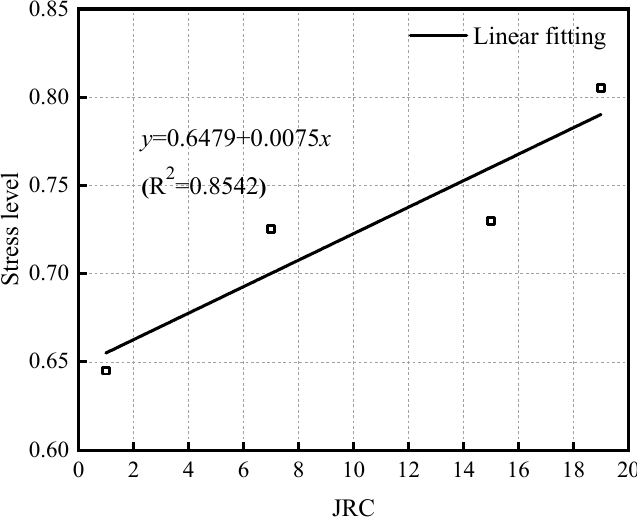
Figure 11. Variations in stress at the energy storage limit of samples with JRC.